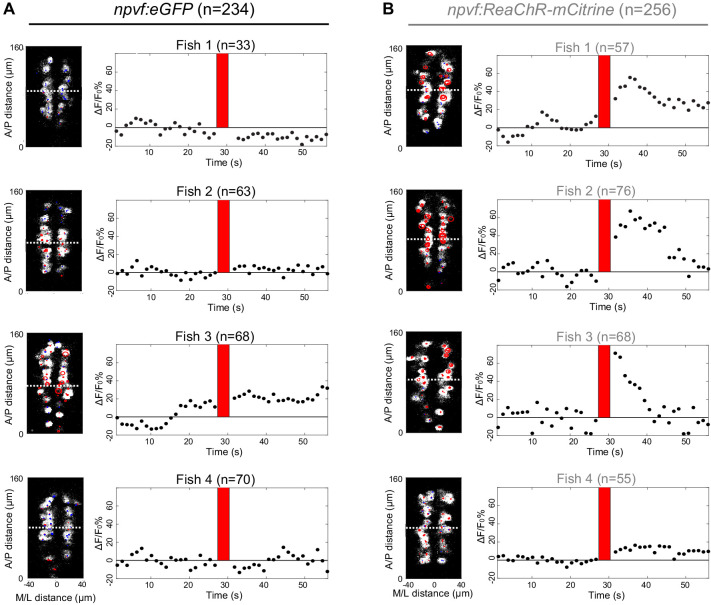
Responses of individual IRa neurons to optogenetic stimulation of NPVF neurons in individual fish.6-dpf Tg(npvf:eGFP); Tg(tph2:GCaMP6s-P2A-tdTomato) (A) and Tg(tph2:ReaChR-mCitrine); Tg(npvf:GCaMP6s-P2A-tdTomato) (B) animals were analyzed for normalized GCaMP6s fluorescence levels in IRa neurons pre- and post-optogenetic stimulation of NPVF neurons. Data from Figure 2 are displayed here as separate fish. Maximum intensity projection images (left) show GCaMP6s fluorescence averaged over the first 10 imaging frames post-stimulation and provide spatial information along the anterior/posterior and medial/lateral axes of the brain. Size of red or blue circle indicates magnitude of normalized GCaMP6s fluorescence increase or decrease, respectively, in response to optogenetic stimulation. Dot plots (right) show average normalized GCaMP6s fluorescence of all IRa neurons for each frame before and after optogenetic stimulation (red line). A, anterior; P, posterior; M, medial; L, lateral. n = number of IRa neurons imaged.